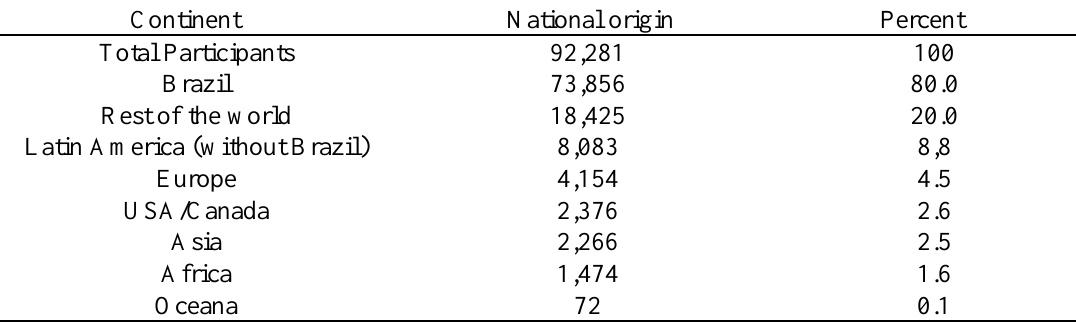
Table 2: WSF 2005 participants by geographical